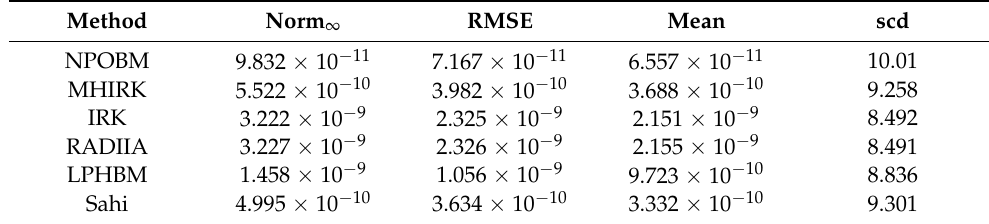
Table 10. Numerical results for Problem 3 with NS = 2 7 where x ∈ [ 0,5 ]